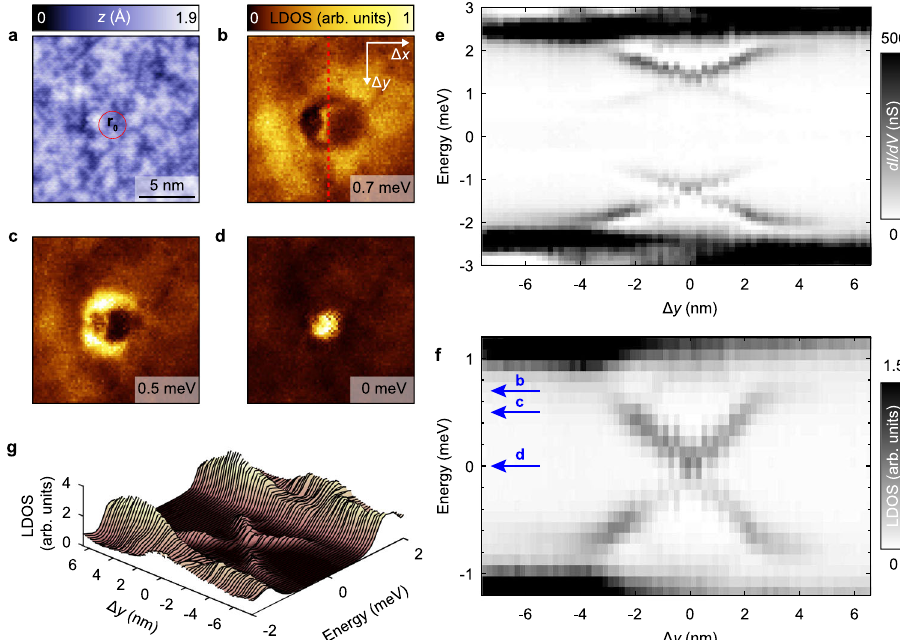
Fig. 2 X-shaped spatial dispersion of impurity resonances in FeTe 0.55 Se 0.45 . a Topographic image at the impurity location ( r 0 indicates the impurity center). No clear signature of the impurity is observed. Setup conditions: V set = − 8 mV, I set = − 100 pA. b – d Spatially resolved LDOS maps at different energies obtained by deconvolution of a dI / dV ( r , V ) map in the same fi eld-of-view as in a . The energy of each LDOS map is indicated at the bottom right corner. e Measured differential conductance intensity plot of a vertical linecut passing through the impurity center r 0 ( Δ y = 0 nm). The linecut was taken along the red dashed line in b . A crossing of the in-gap resonances at the impurity center is observed. Setup conditions: V set = − 8 mV, I set = − 1.6 nA. Lock- in modulation is V mod ¼ 100 μ V peak-to-peak, f Deconvolution of the measured spectra in e shows an X-shaped dispersion of the sub-gap states crossing the Fermi level at the impurity center. The blue arrows indicate the energy of the maps in b – d . g Series of LDOS spectra depicting the X-shaped spatial dispersion shown in f